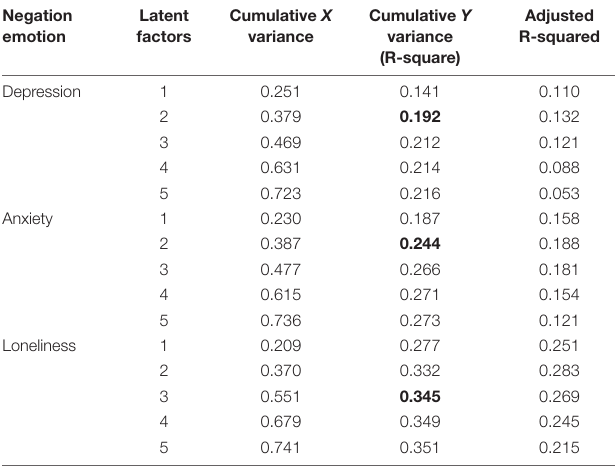
TABLE 2 | Explained variance in negative